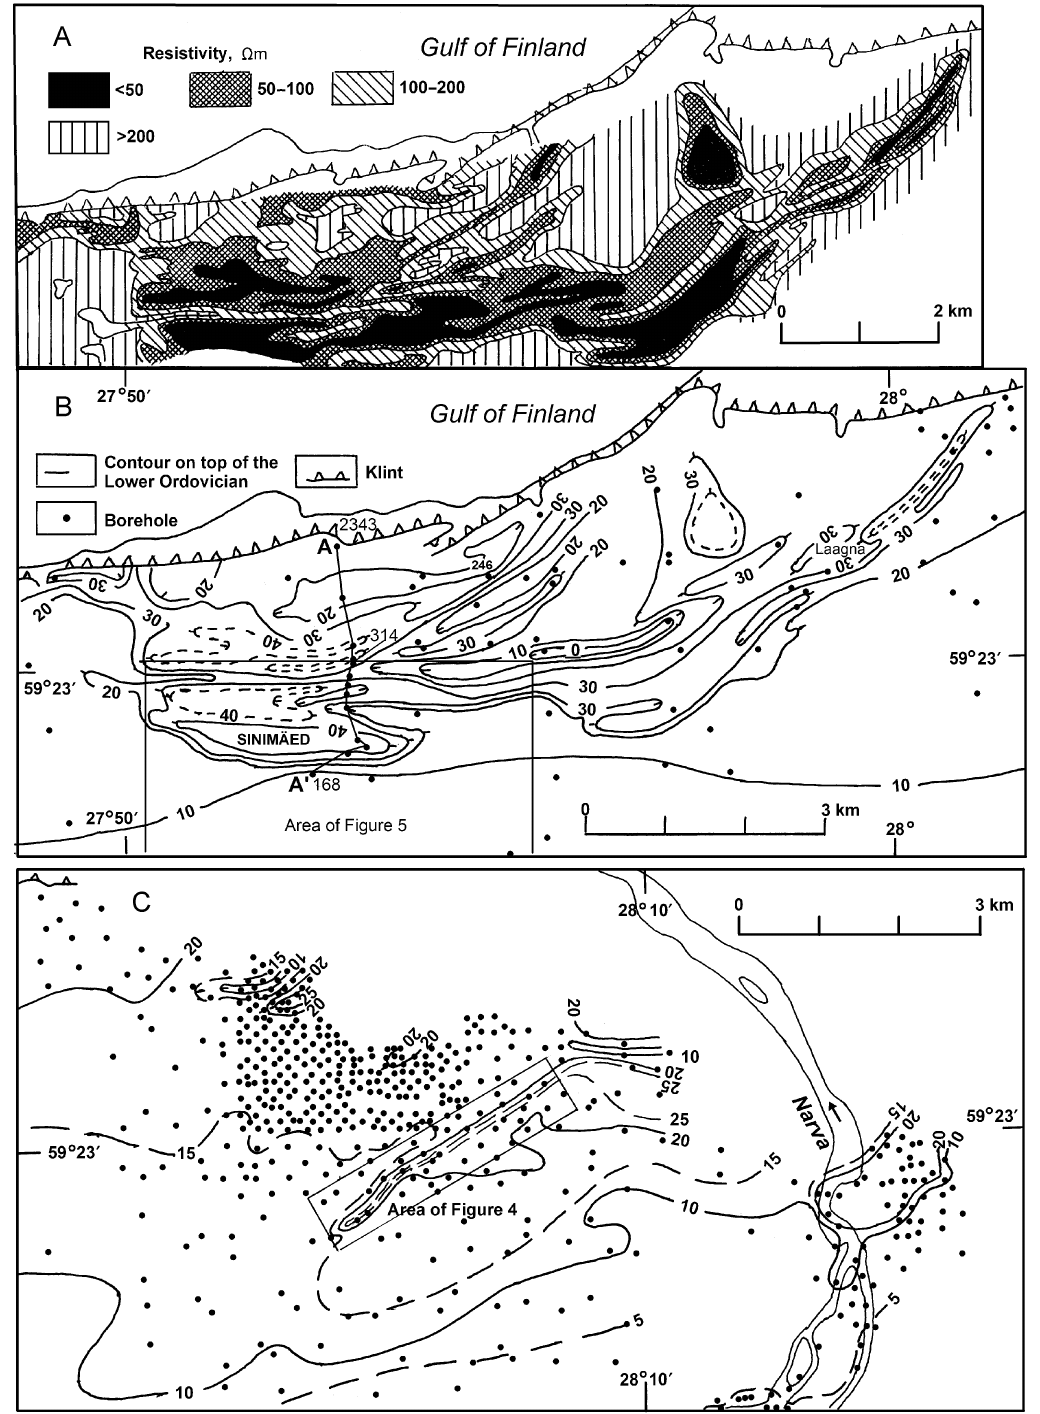
Fig. 2. Diapirs, northeastern Estonia: resistivity ( A ) and structure ( B , C ) maps (modified after Vaher & Mardla 1969). For cross section along line A(cid:150)A ′ see Fig.